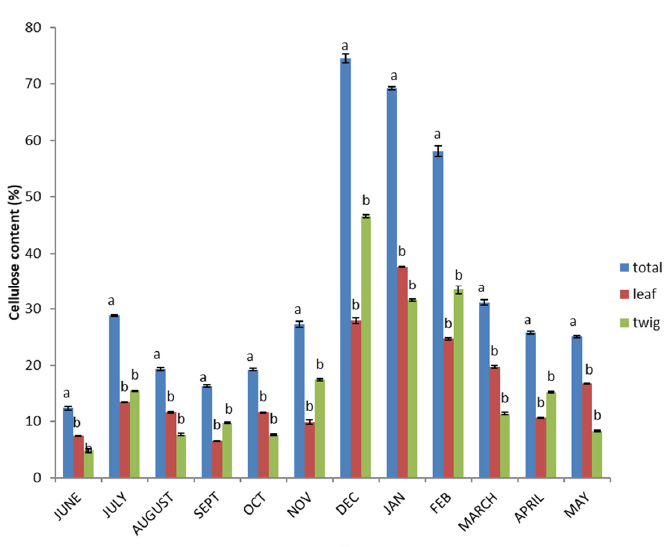
Figure 2a. Monthly cellulose content in the litter fall of bamboo stands in a regenerating forest, Ile-Ife. *Vertical bars of the same alphabet in a month are not significantly (p > 0.05) different using Duncan Multiple Range Test (DMRT).